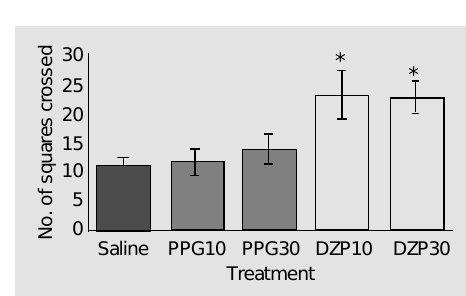
Figure 1 - Effects of diazepam (DZP) and propylene glycol (PPG) on the number of head-dips in the hole-board test. PPG (10%, PPG10), 30% PPG (PPG30), and 0.5 mg/kg diazepam diluted in 10% PPG (DZP10) or 30% PPG (DZP30) were used. Each col- umn represents the mean ± SEM. *P<0.05 and **P<0.01 compared to saline (ANOVA).